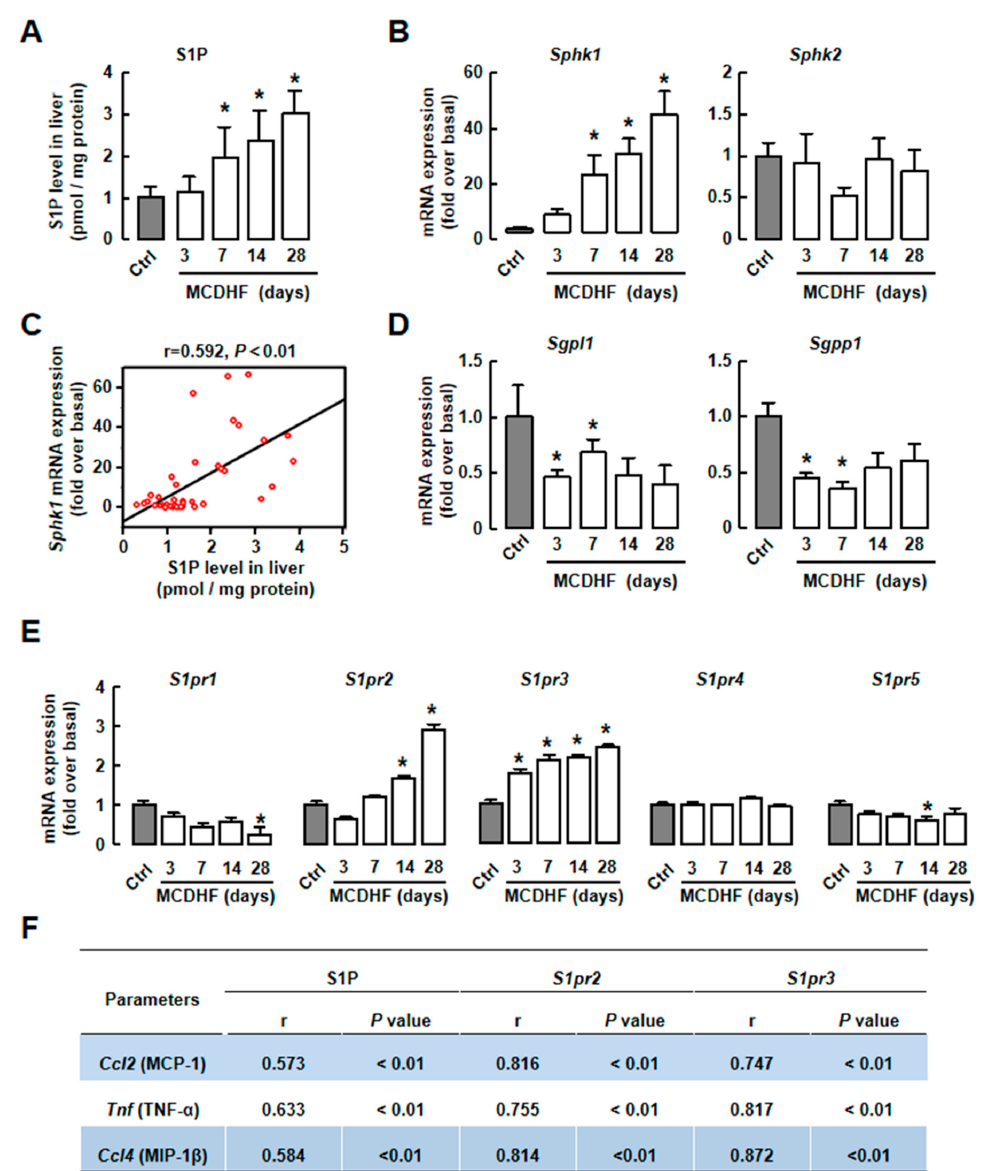
Figure 2. The MCDHF-diet-induced hepatic inflammation was associated with increasing levels of S1P / S1PR 2 / 3 . ( A ) The S1P level in liver tissues was analyzed by ELISA. ( B ) The mRNA expressions of SphK1 and SphK2 in MCDHF-diet-fed mice. ( C ) The relationship between S1P level and SphK1 mRNA expression in liver were analyzed by regression analysis. ( D ) Hepatic mRNA expressions of S1P lyase and S1P phosphatase were determined by RT-qPCR. ( E ) Hepatic mRNA expressions of S1pr1-5 were determined by RT-qPCR. ( F ) The relationship between hepatic S1P level or S1pr2 / 3 mRNA expressions and pro-inflammatory factor expressions were analyzed by regression analysis ( n = 42). Correlation coe ffi cients ( r ). Data are presented as the mean ± SEM. * p < 0.05 versus control group ( n = 6 for each group in each